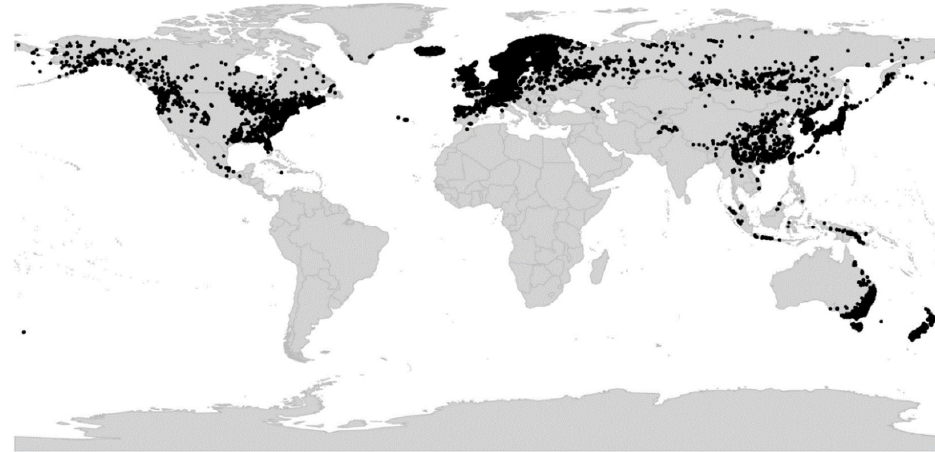
Figure 26. Global distribution of Viola sect. Plagiostigma . Discussion .—Sect. Plagiostigma is phylogenetically an allotetraploid CHAM + MELVIO lineage; unlike all other sections except sect. Danxiaviola it has retained the CHAM homoeolog for ITS (Figure 6). It is karyologically characterised by the secondary base chromosome number x = 12, and morphologically by the clavate, margined or bilo- bate, beardless style, and the occurrence of seasonal cleistogamy. Here, we recognise a narrowly circumscribed sect. Plagiostigma that comprises the six Beckerian greges [1] hav- ing a ‘plagiostigmate’ style shape and a secondary base chromosome number x’ = 12, i.e., sect. Nomimium greges Adnatae p.p., Bilobatae , Diffusae , Serpentes p.p., Stolonosae , and Vag-